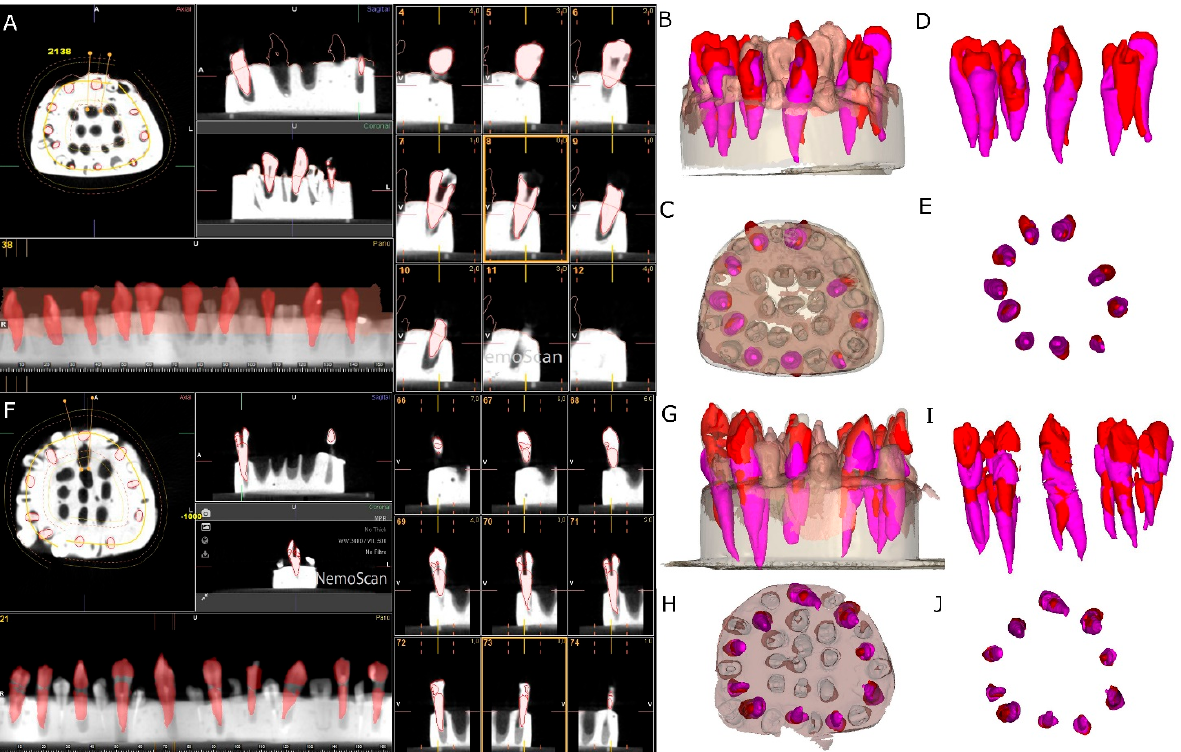
Figure 5. ( A ) Segmented teeth on the postoperative CBCT scan (red teeth), ( B ) lateral view and ( C ) apical view of the experimental models and ( D ) lateral and ( E ) apical view of the planned (pink teeth) and performed (red teeth) autotransplanted teeth without model of the conventional freehand technique study group. ( F ) Segmented teeth on the postoperative CBCT scan (red teeth), ( G ) lateral and ( H ) apical view of the experimental models and ( I ) lateral and ( J ) apical view of the planned (pink teeth) and performed (red teeth) autotransplanted teeth without model of the computer-aided static navigation technique.